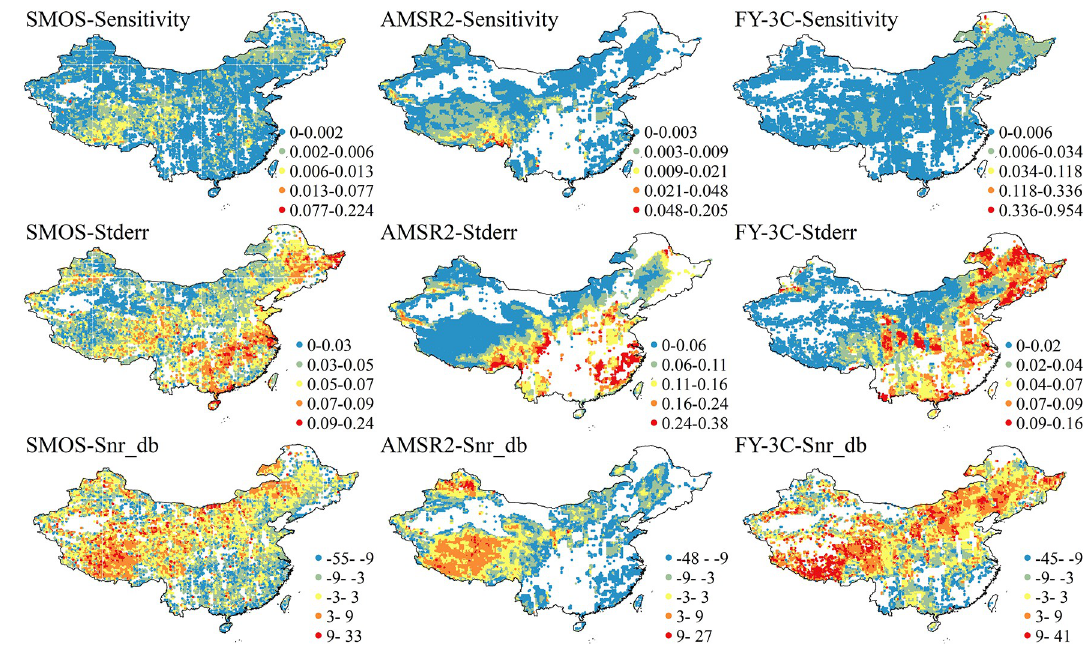
Fig 9. Distribution of parameters across China for SMOS, AMSR2 and FY-3C soil moisture products given by triple collocation analysis; results are only shown for grids which all three datasets were positively